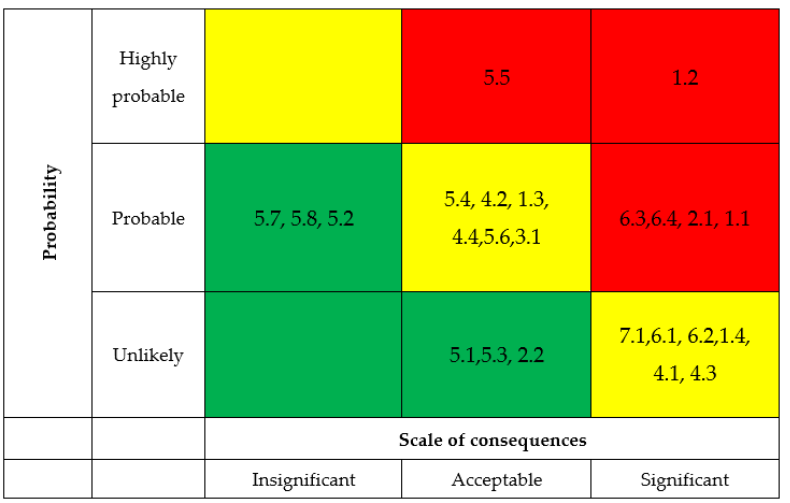
Figure 4. Environmental risk map.